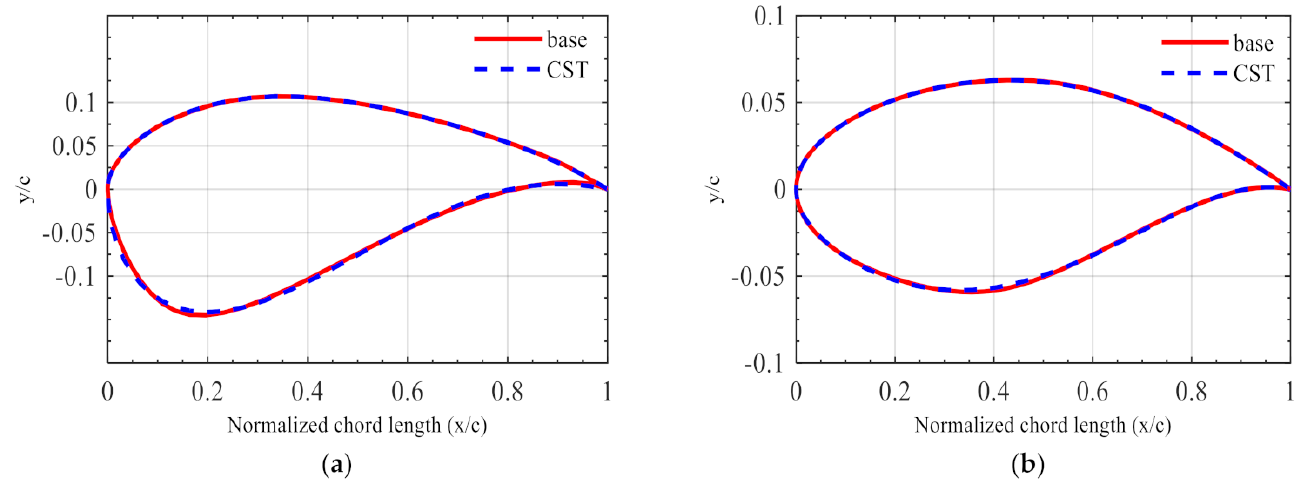
Figure 1. Airfoil generated by CST parameterization ( a ) S-821 and ( b ) RAE-2822.